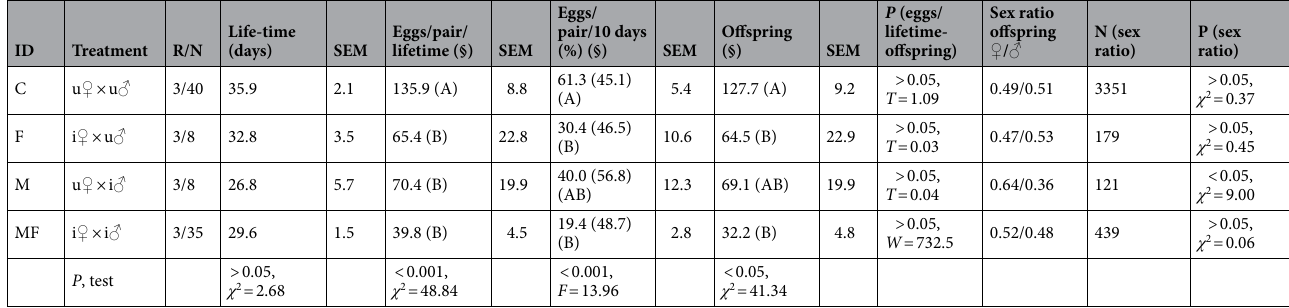
Table 1. Lifetime, fecundity (oviposition) and fertility (offspring) of SWD pairs inoculated with T. suzukii spores at larval stage. Sex ratio of resulting offspring was determined after eclosion of progeny. ID = treatment (C = untreated control, F = female infected, M = male infected, MF = both infected), treatment: ♀ = female, ♂ = male, u = uninfected, i = infected, R/N = number of replicates and total pairs, (§) = significance letter (< 0.05), SEM = standard error of mean, N (sex ratio) = total number of offspring analysed for sex. Lifetime, eggs/pair/lifetime, eggs/pair/10 days, offspring are shown as